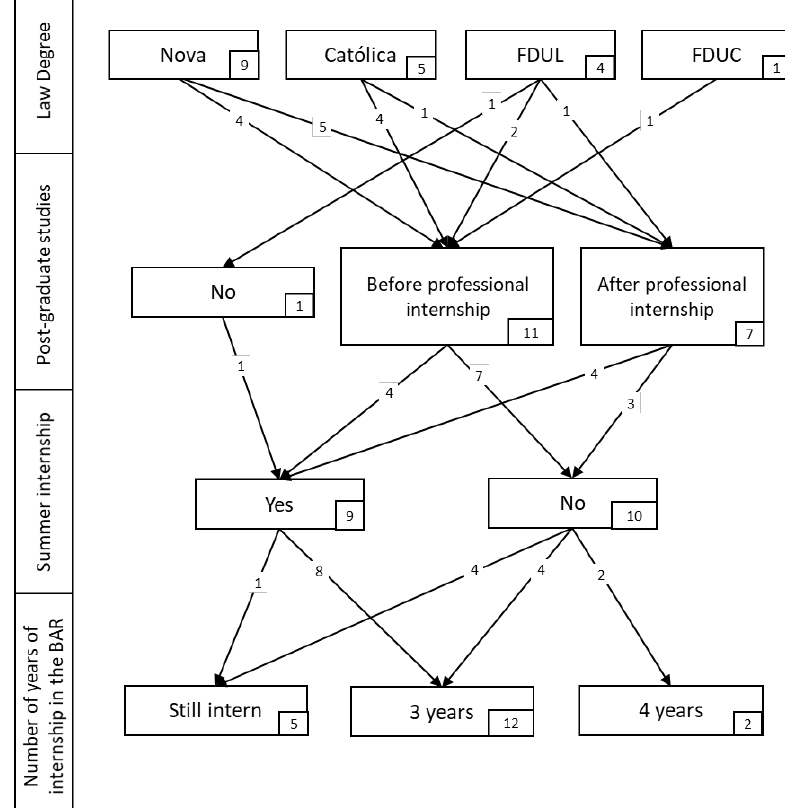
Figure 1. Academic and professional trajectories of the nineteen lawyers’ inter-